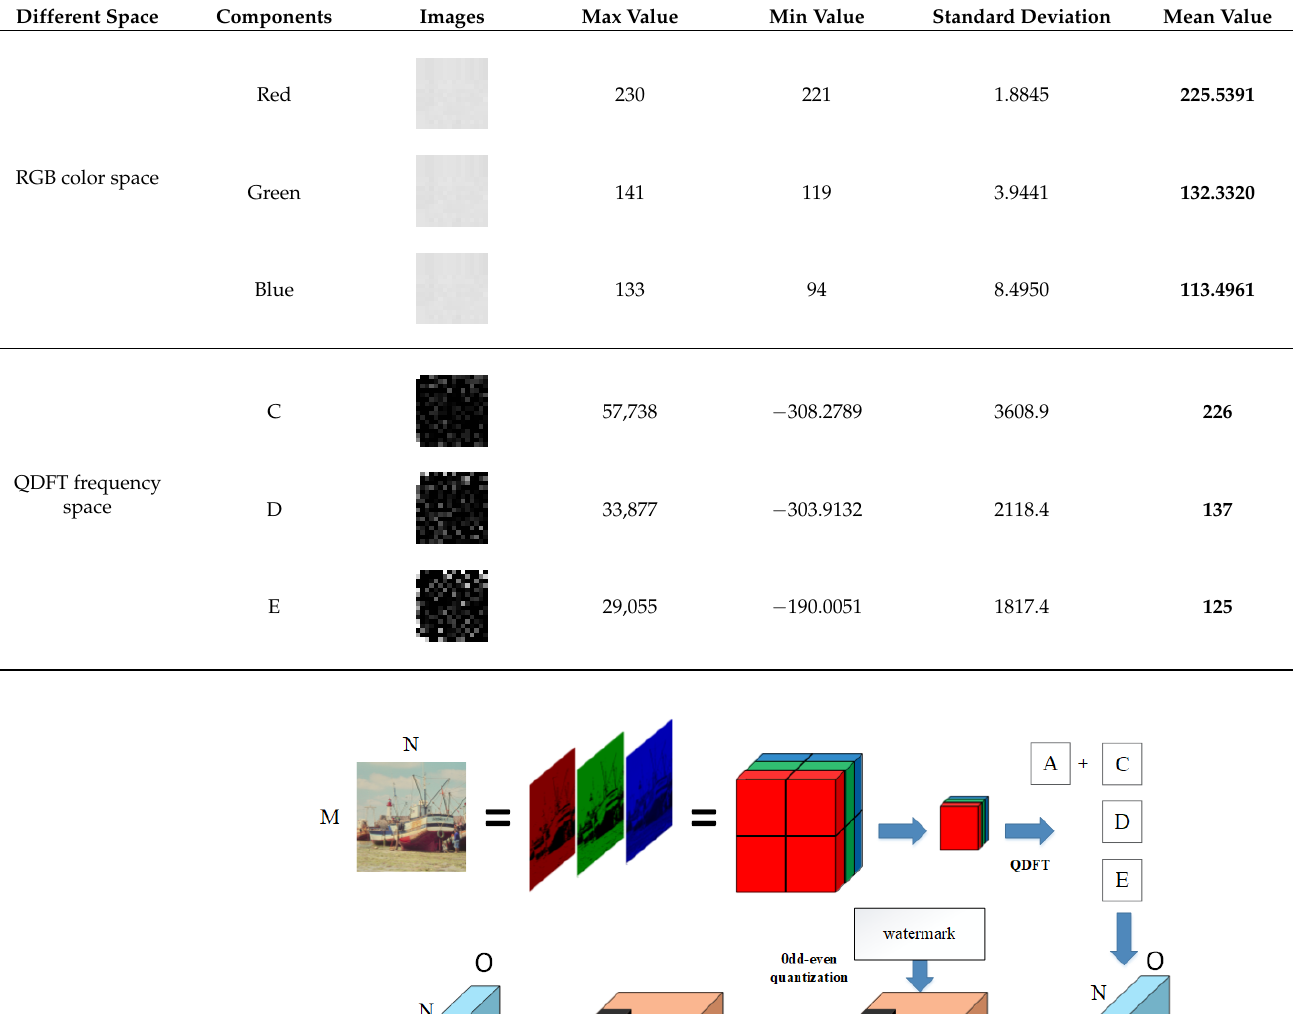
Table 1. Distribution of different space components.